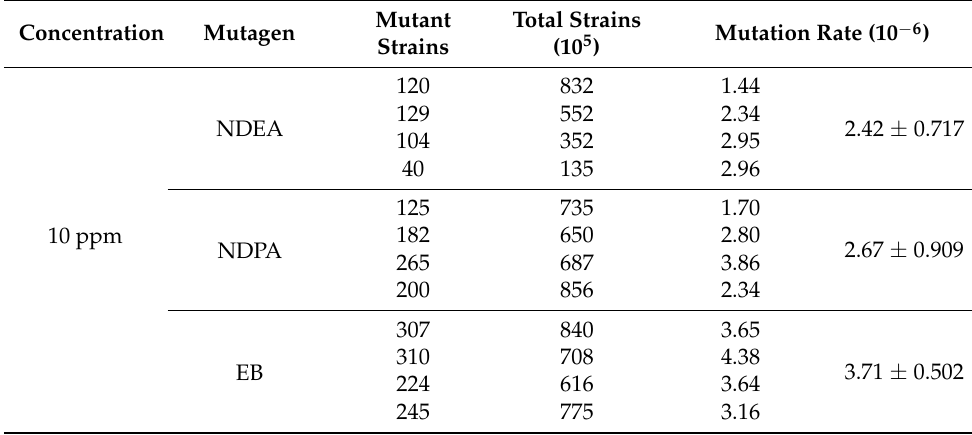
Table 3. Mutation rate of rpsL induced by